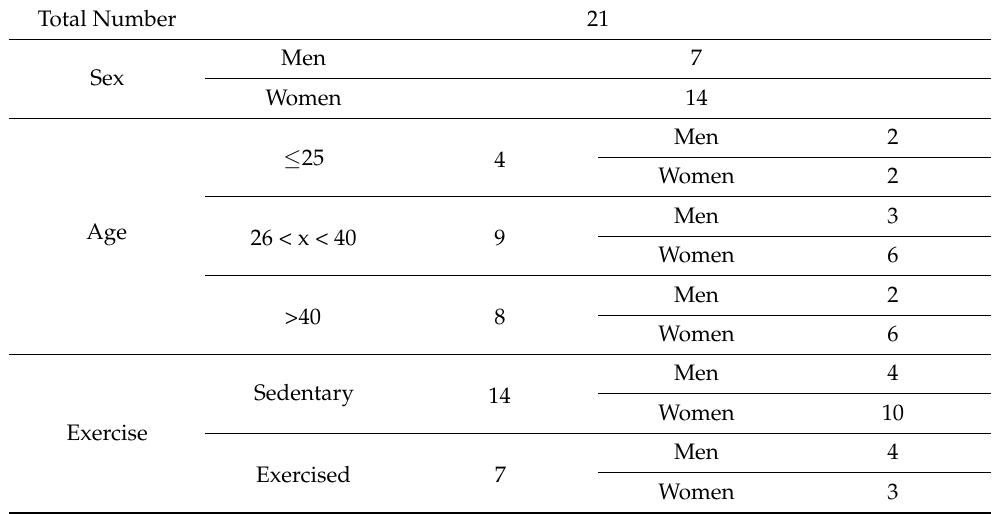
Table 1. Demographics of subjects participating in the